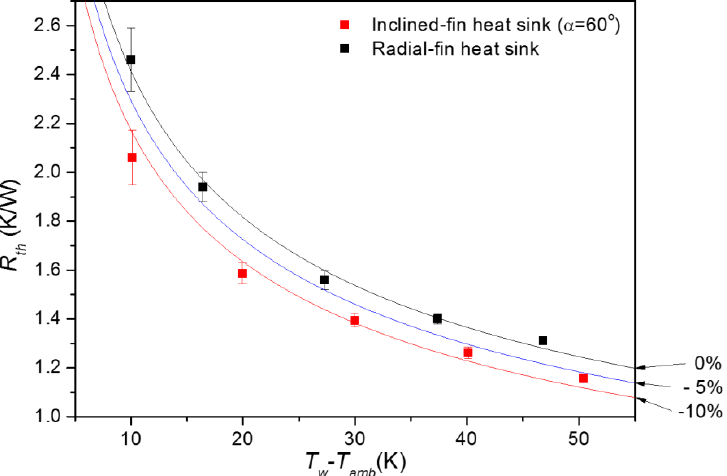
Figure 5. Comparison of experimental data for minimal resistances between the inclined fin heat sink and the radial fin heat sink ( H = 30 mm, N = 36).